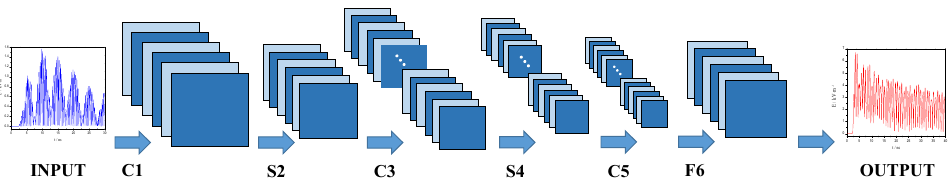
Figure 4. CNN structure of proposed method.